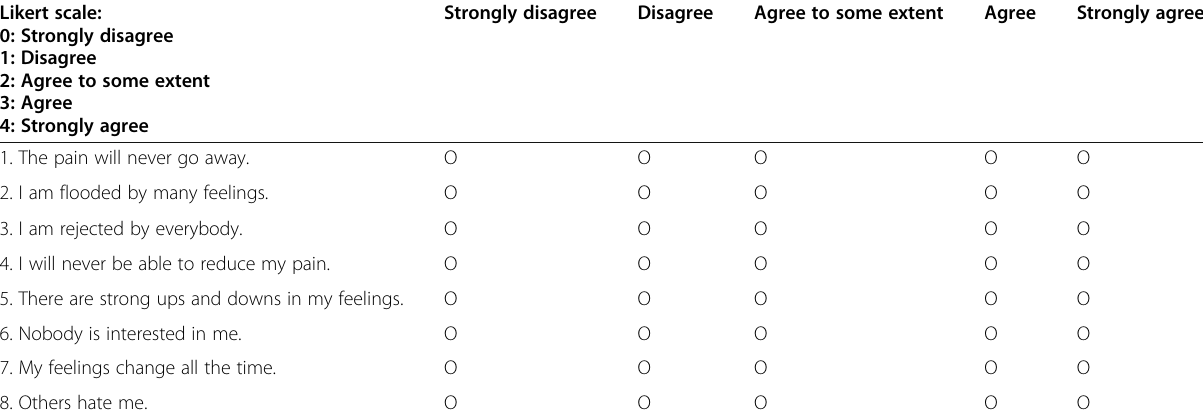
Table 2 Orbach and Mikulincer Mental Pain Scale-8 Likert scale: 0: Strongly